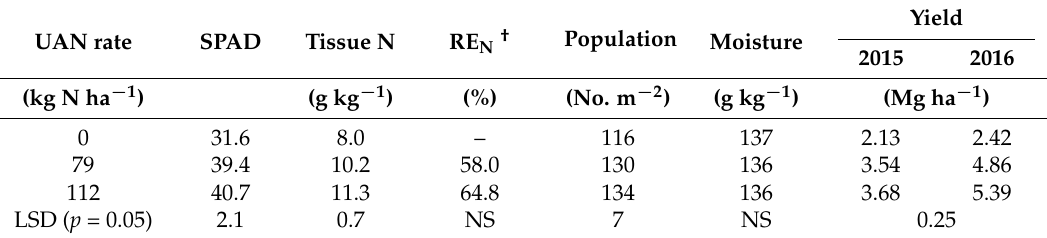
Table 3. Leaf SPAD meter readings, tissue N concentration, N recovery efficiency (REN), plant population, grain moisture, and yield response to urea ammonium nitrate (UAN) rates in 2015 and 2016. Data were combined over factors in the absence of significant interactions.